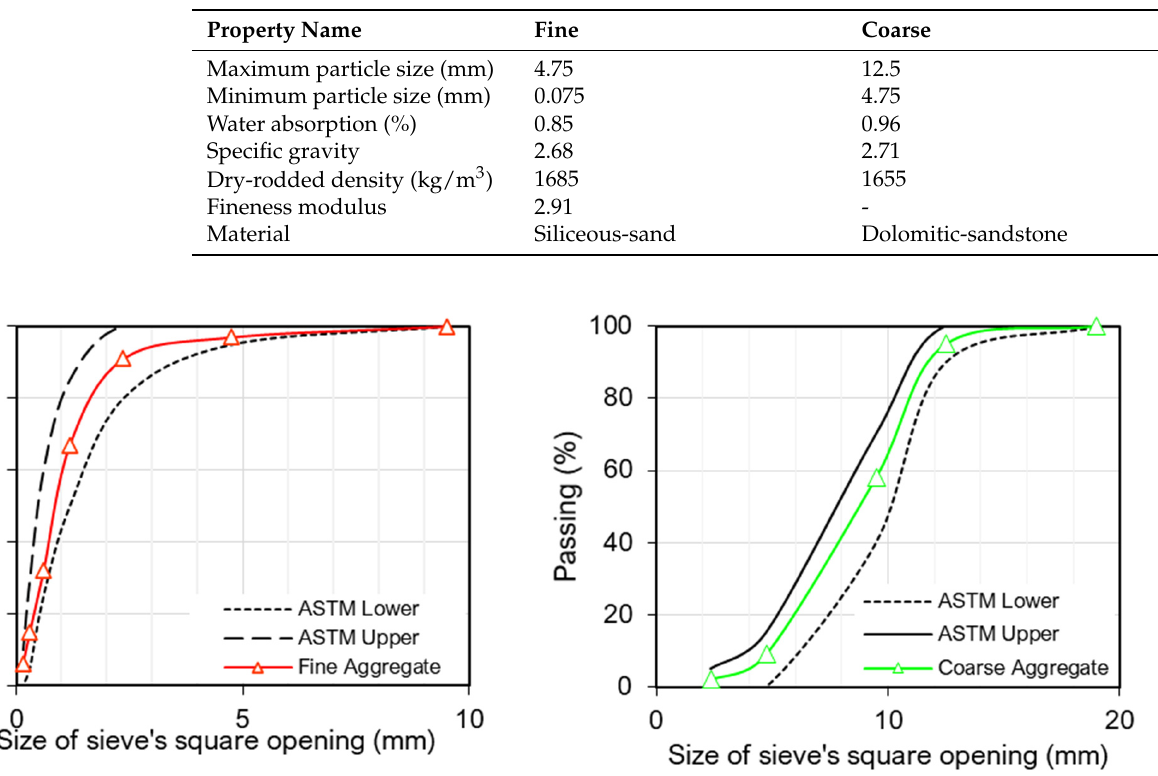
Figure 1. Particle size distribution: ( a ) granulometry of binder materials; ( b ) SEM observation of silica fume particles. Table 2. Properties of aggregates.